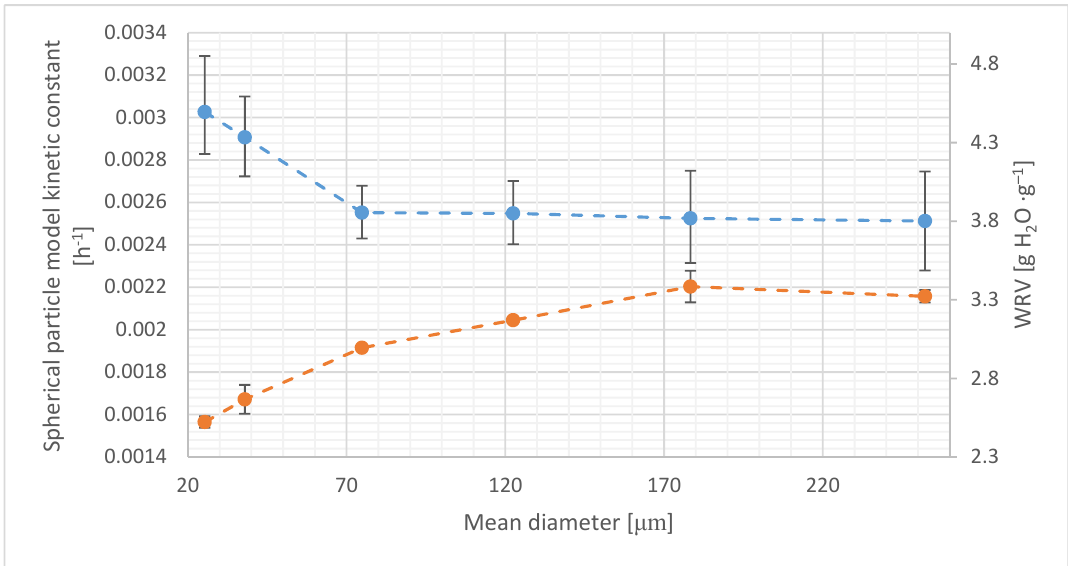
Figure 4. WRV compared to spherical shaped particle model kinetic constant values. For k constant (top) and WRV (bottom) points, the error bars represent the 95% confidence interval and standard error, respectively.